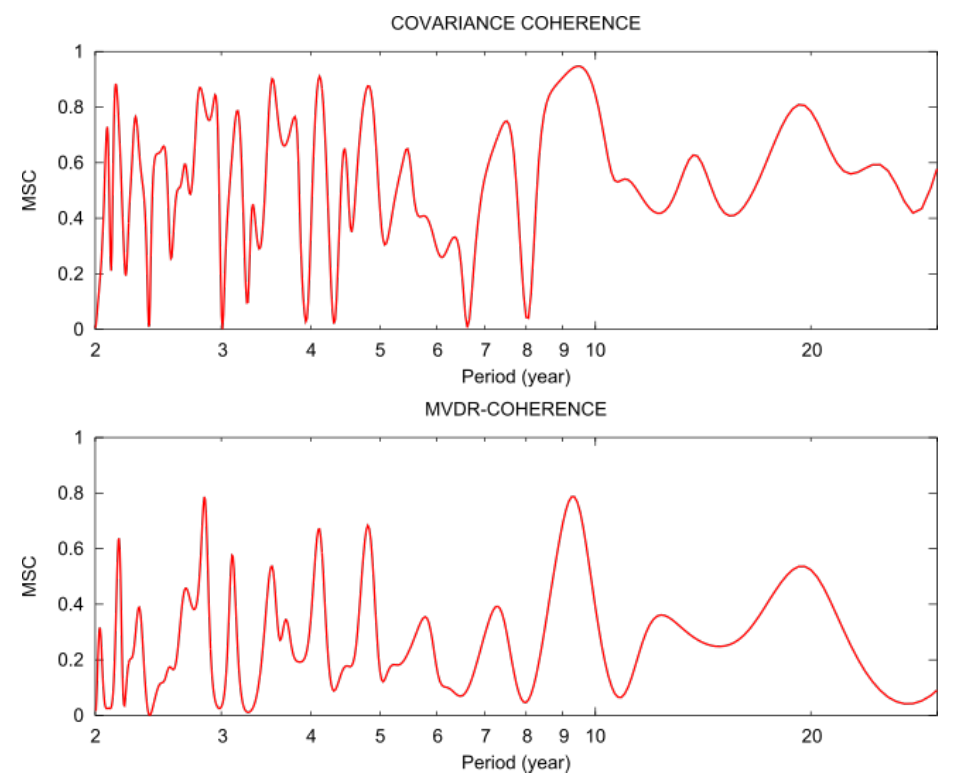
Figure 10. Spectral coherence between HadCRUT4 global surface temperature-independent intervals (1861–1937 and 1937–2013). Coherent spectral peaks are observed at about 2.14, 2.85, 3.16, 3.5, 4.1, 4.8, 7.5, 9.3, 13.8 and ∼ 20 year. The covariance coherence analysis uses L = 52 year moving